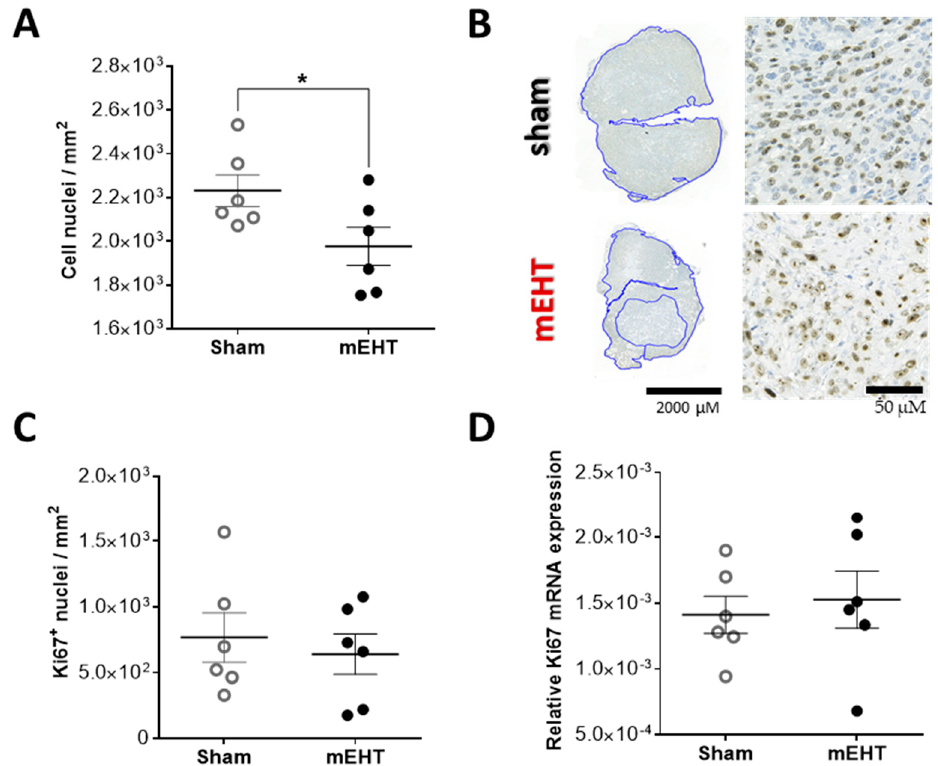
Figure 5. Ki67 expression 24 h after two mEHT treatments. ( A ) Number of all cell nuclei in the intact tumor area; ( B ) Ki67 staining in the viable tumor tissue (blue assigned areas), representative sections; ( C ) Number of strong Ki67-positive nuclei; ( D ) Ki67 mRNA expression in tumor tissue (normalized to 18 S rRNA). Mean ± SEM, unpaired t -test, n = 6/group, * p = 0.0494 .